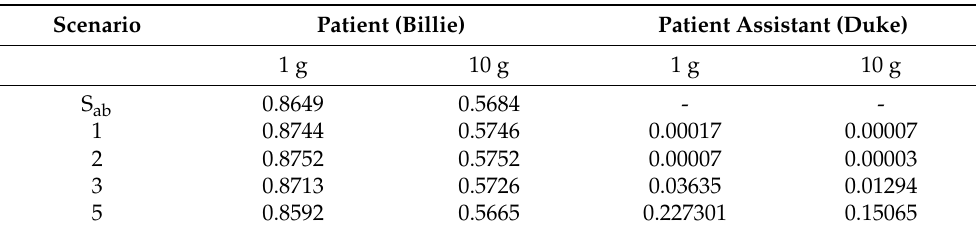
Table 4. Peak spatially averaged SAR (W/kg) in Billie (patient) and Duke (patient assistant) according to body RF coil (input power = 1 W).